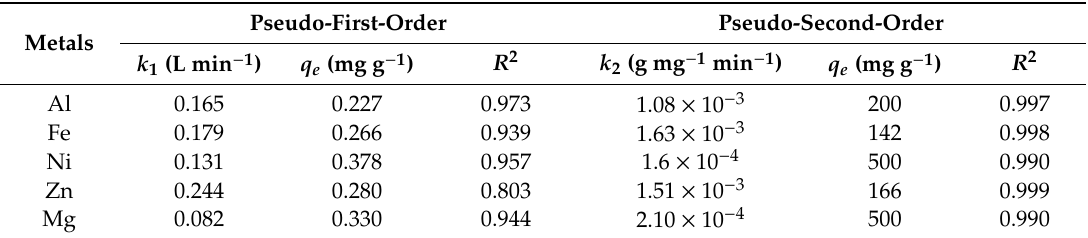
Table 3. Kinetic model parameters for adsorption of metal ions on